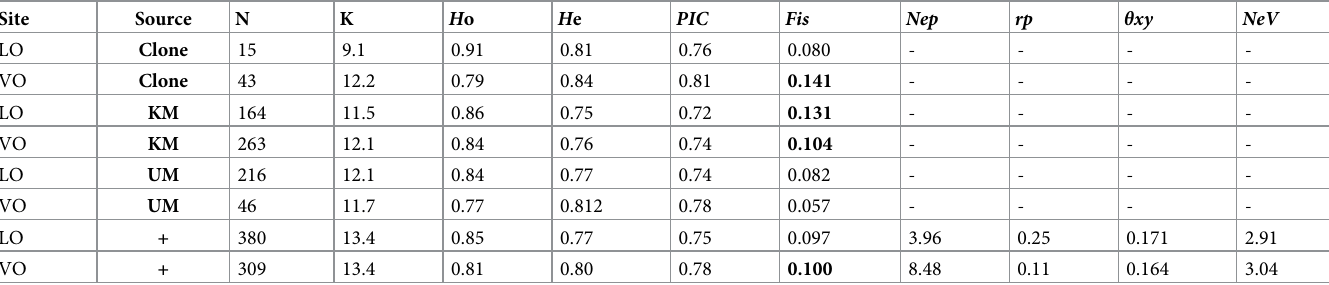
He, expected heterozygosity; Ho, observed heterozygosity; k, number of alleles detected per locus; PIC, polymorphism information content KM, progeny with known male; UM, Progeny with unknown male (sired by wild trees). + , all seedling sired by known and unknown males; F(is), fixation index for parent and progeny; N ep , The effective number of pollen donors mating with each tree, n ep ,was the number of pollen donors detected from paternity results, where n p was the number of progeny analyzed, P i was the proportion of progeny sired by male i (Bittencourt et al., 2007); rp, paternity correlation among offspring of the average seed tree (rp: 1/Nep; Bittencourt et al., 2007); θ xy, coancestry coefficient = θ xy, 0.125 (1 + Fp) (1 + rp); NeV, variance effective size = NeV, 0.5/ θ xy; � p < 0.05 (Bittencourt et al.,